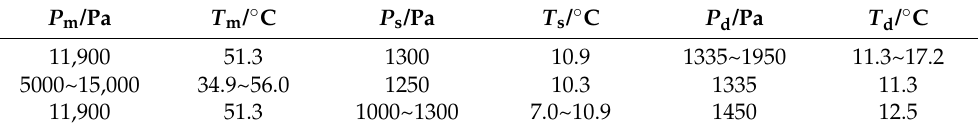
Figure 1. Structure and size of the steam ejector. Table 1. Computation parameters. Table 1. Computation parameters.